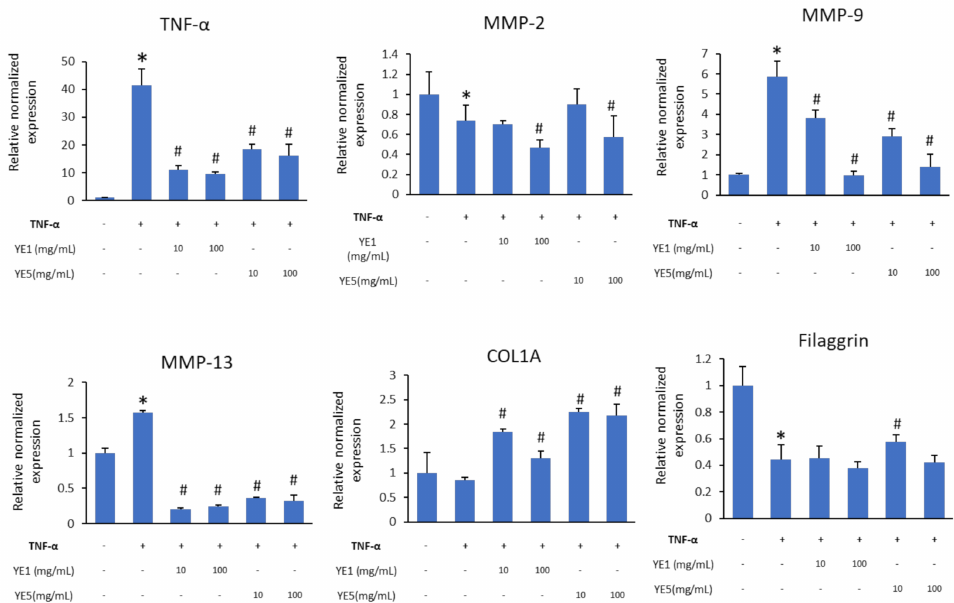
Figure 5. Gene expression of inflammatory mediators, collagen type-1, and skin barrier-related gene in TNF- α -induced HaCaT cells. Student’s t -test was used for statistical analyses, * p < 0.05 compared with cells not treated with TNF- α . # p < 0.05 compared with the control (+ TNF- α